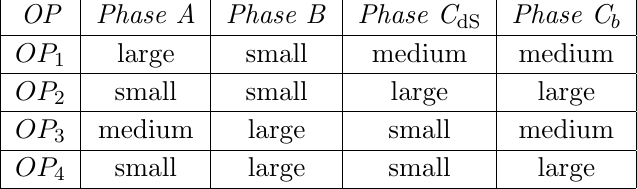
Table 1 . Order parameters used in CDT phase transition